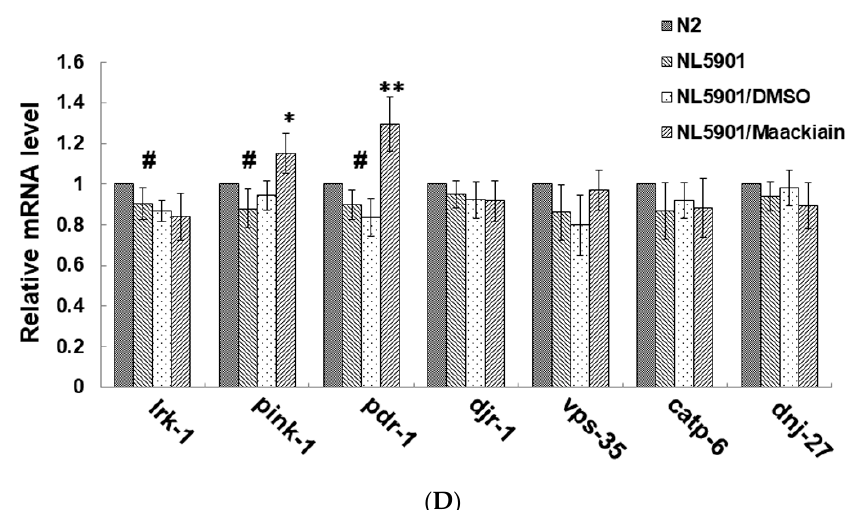
Figure 6. Maackiain (MK) treatment enhanced proteasome and autophagy activity and increased pdr-1 expression in the transgenic C. elegans models. L3 stage worms of the NL5901 or DA2123 strain were treated with or without MK and cultured until the third day of adulthood. ( A ) The activity of the proteasome was monitored in the extract of NL5901 worms from different groups containing equal amounts of total protein. # shows significant differences between N2 and NL5901 worms ( p < 0.01); * shows significant differences between the MK ‐ untreated and MK ‐ treated worms (** p < 0.01). ( B ) Representative GFP fluorescence images of positive puncta in lateral hypodermal seam cells of DA2123 worms are displayed. Scale bar = 10 µm. ( C ) The number of positive puncta was counted in the lateral epidermal seam cell of DA2123 worms. At least 50 worms were counted in each experimental group, and at least 100 seam cells were counted for each worm. * shows significant differences between MK ‐ untreated and MK ‐ treated worms (* p < 0.05, ** p < 0.01). ( D ) The expression level of the PD ‐ associated genes was quantified by qPCR in NL5901 worms. # shows significant differences between N2 and NL5901 worms ( p < 0.05); * shows significant differences between the MK ‐ untreated and MK ‐ treated NL5901 worms (* p < 0.05, ** p < 0.01).